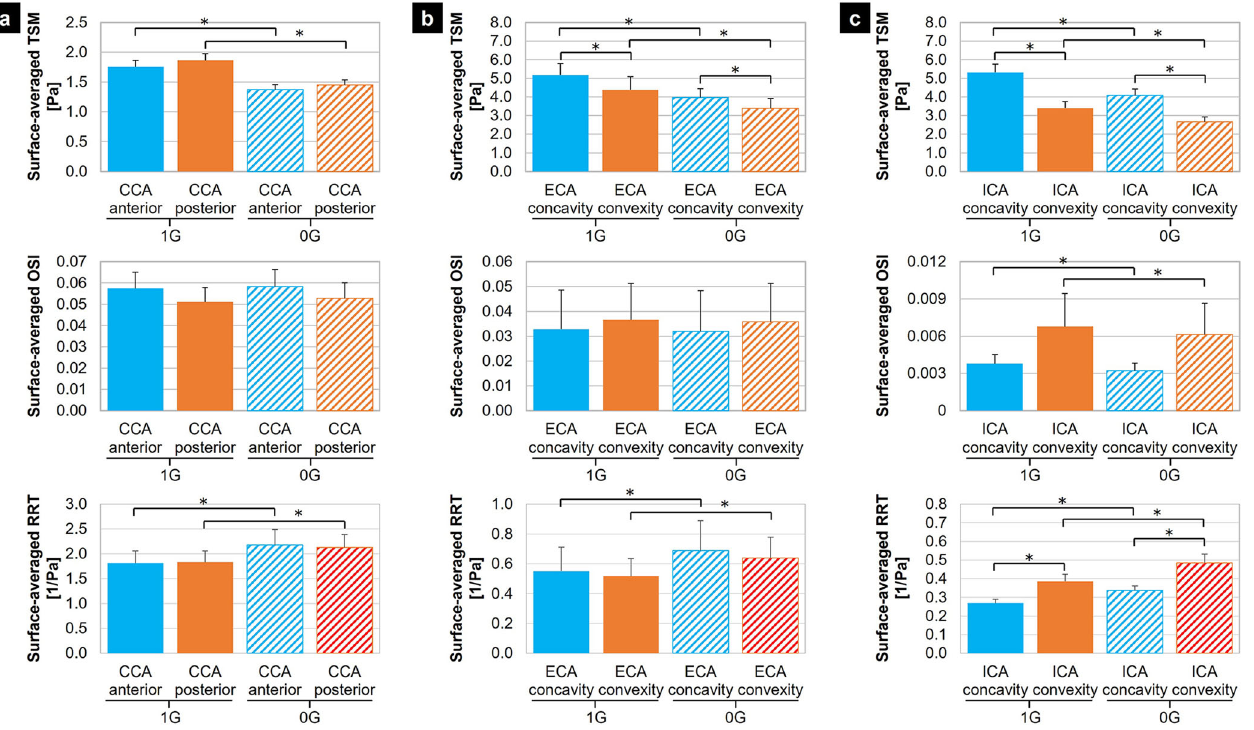
Fig. 4 Regional WSS characteristics computed under 1G and 0G. Surface-averaged TSM, OSI and RRT extracted from: a the CCA, b the ECA, and c the ICA (error bar: standard error; n = 16; * p < 0.05; paired Student t -test).